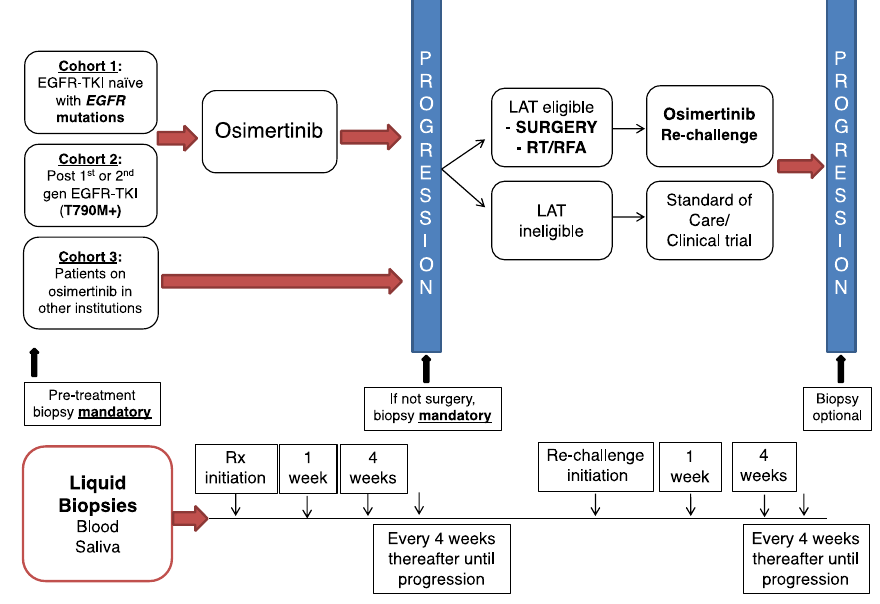
Figure 1. Clinical protocol